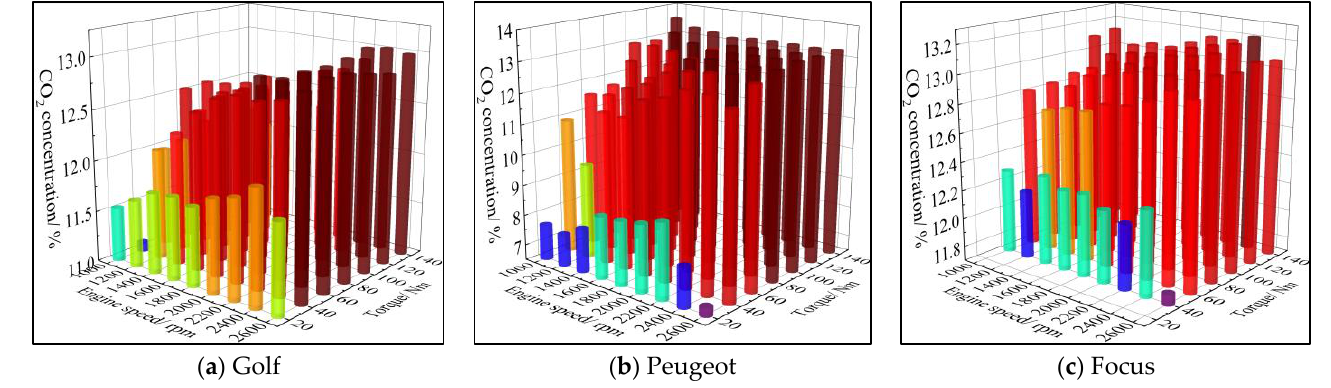
Figure 12. CO 2 concentration vs. engine speed and torque.